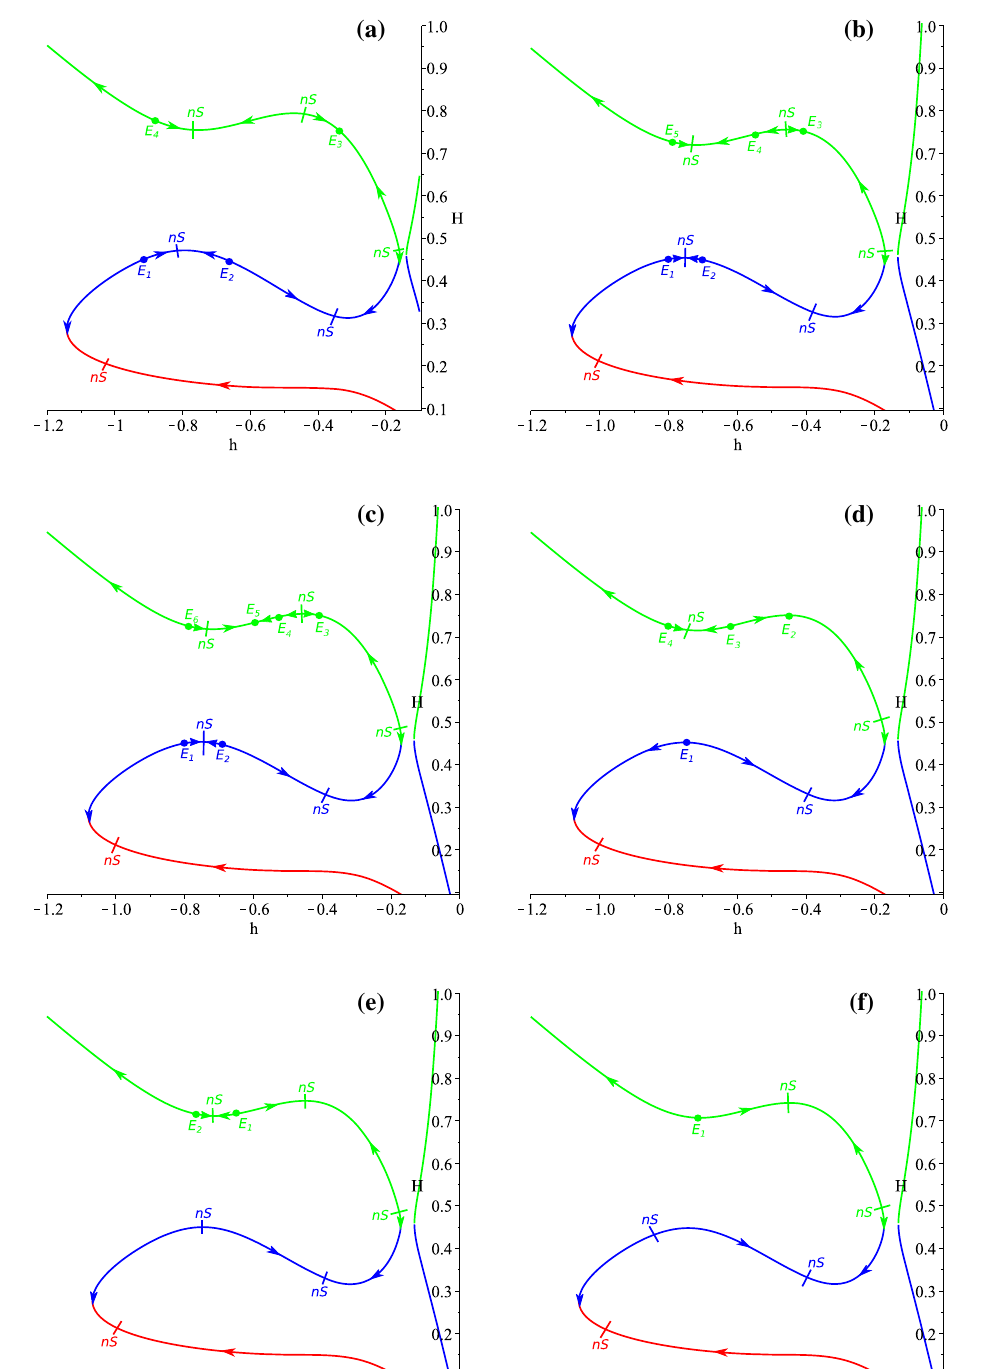
Fig. 10 The fine structure of the solutions in the α > 0, β > 0 panel and μ = μ 4 = 1 / 6 on f panel. Different colors correspond to D = 4 vacuum case: μ 1 < μ < μ 3 on a panel, μ = μ 3 on b panel, the different branches (red – to H 1 , blue – to H 2 and green – to H 3 , in μ > μ > μ μ = μ / 6 > μ > μ accordance with the designation in Fig. 9) (see the text for more details) 8 3 on c panel, 8 on d panel, 1 8 on e entire μ > μ 1 we have only P 1 , 0 → K 1 as realistic com- pactification regime; all the regimes within fine structure are